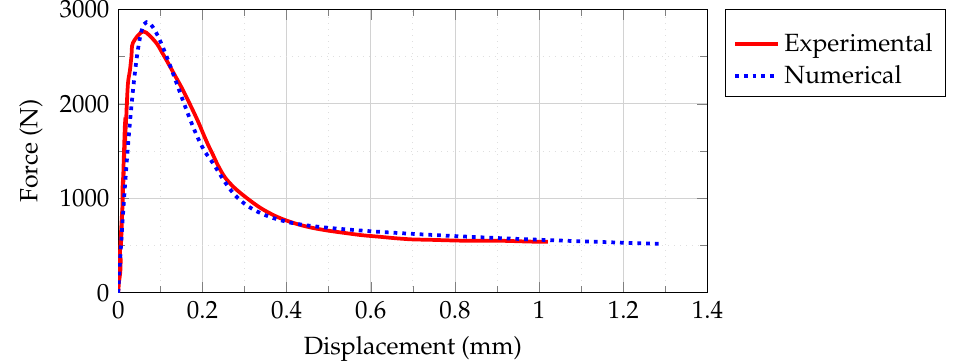
Figure 13. Comparison of empirical data obtained by [25] and computational lateral out-of-plane load-displacement